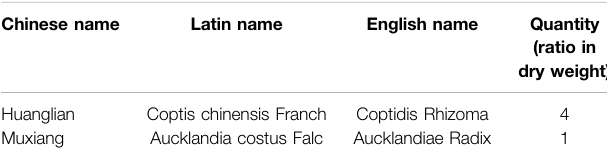
TABLE 1 | Composition of Xianglian